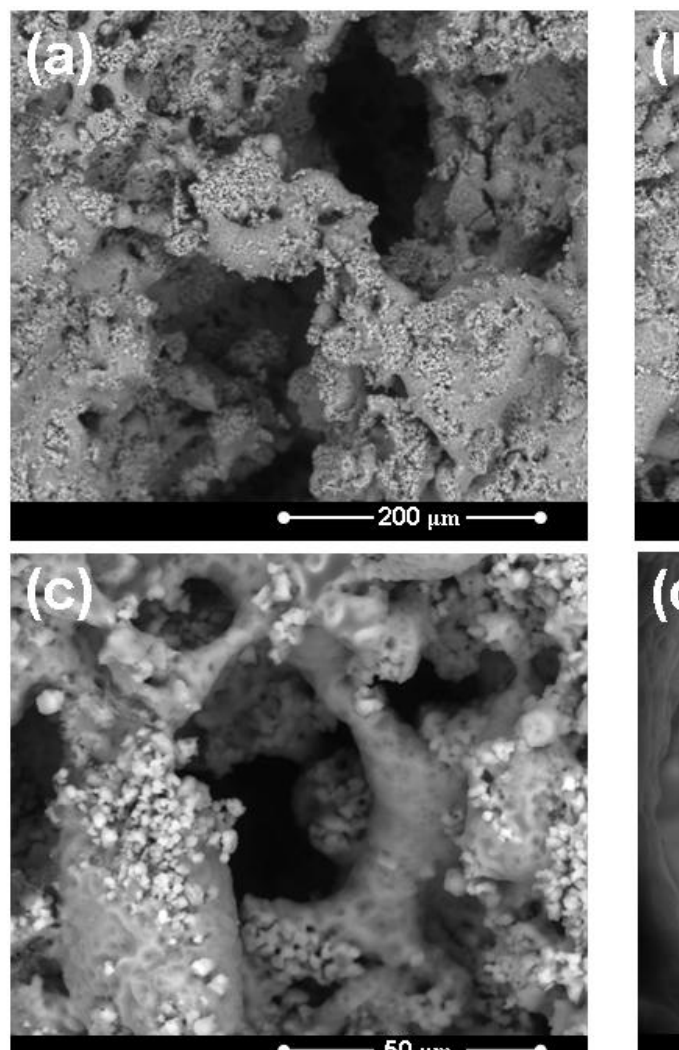
Figure 9. Micrographs of the HA/BG_Ca scaffolds microstructure: detail of the internal structure at different magnification degrees. The sample was treated at 750 °C for 3 hours.